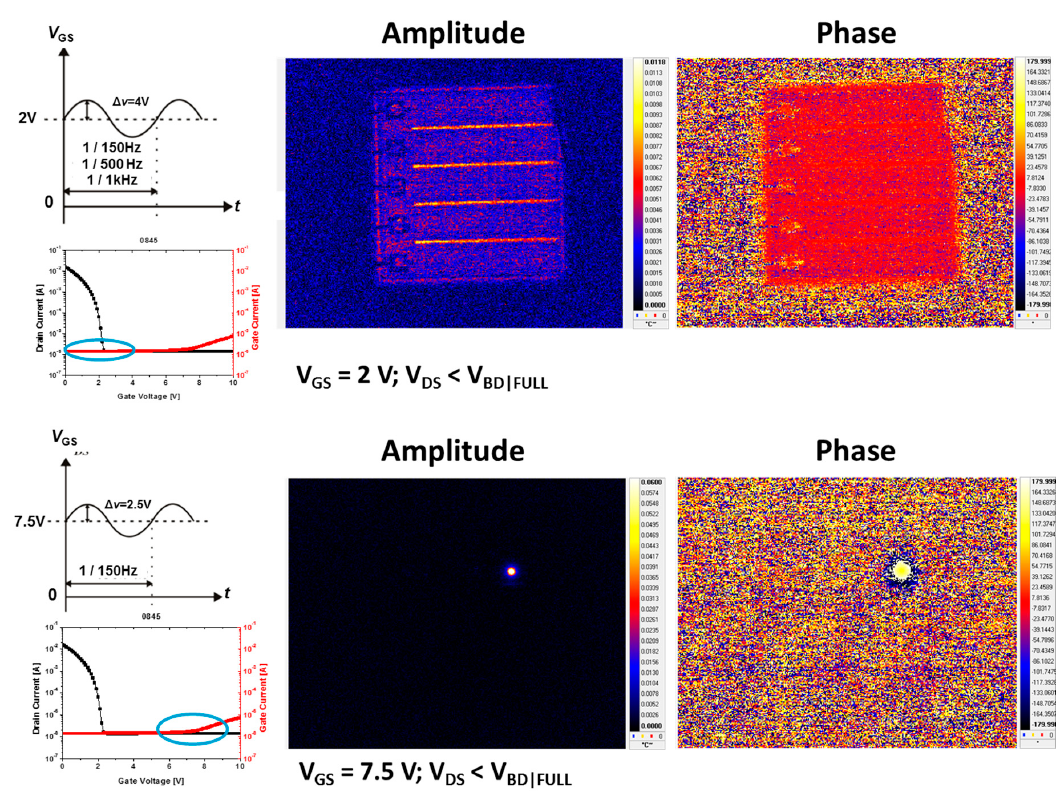
Figure 10. Lock-in thermography amplitude and phase images, obtained with a voltage Gate modulation of Δ V = 4 V, for a V-JFET sample biased at V GS = 2 V ( top side ), and at V GS = 7.5 V ( bottom side ). A hot spot responsible of the Gate leakage increase is observed in the second